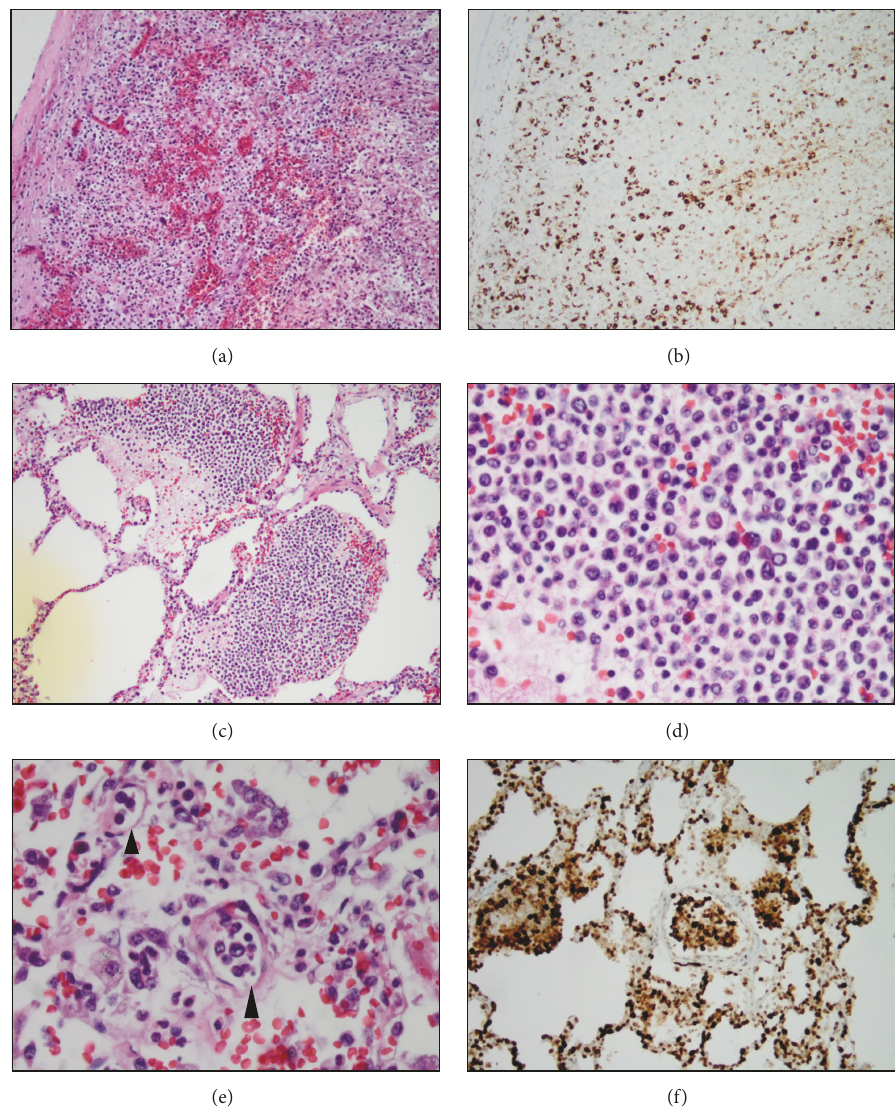
Figure 6: Representative autopsy sections from spleen and lung. Lymphoma cells were not overtly discernible on H&E section ((a) 100x magnification) but clearly identified by immunostains ((b) CD30 staining) in the spleen. In the lung parenchyma, lymphoid infiltrates were prominent with predominantly small to medium sized cells (H&E staining; (c) 100x magnification; (d) 400x magnification). Intravascular lymphoma involvement was evident morphologically ((e) H&E staining, 400x magnification) and confirmed by immunostains ((f) CD30, 200x magnification). Black arrowheads in (e) refer to intravascular lymphoma